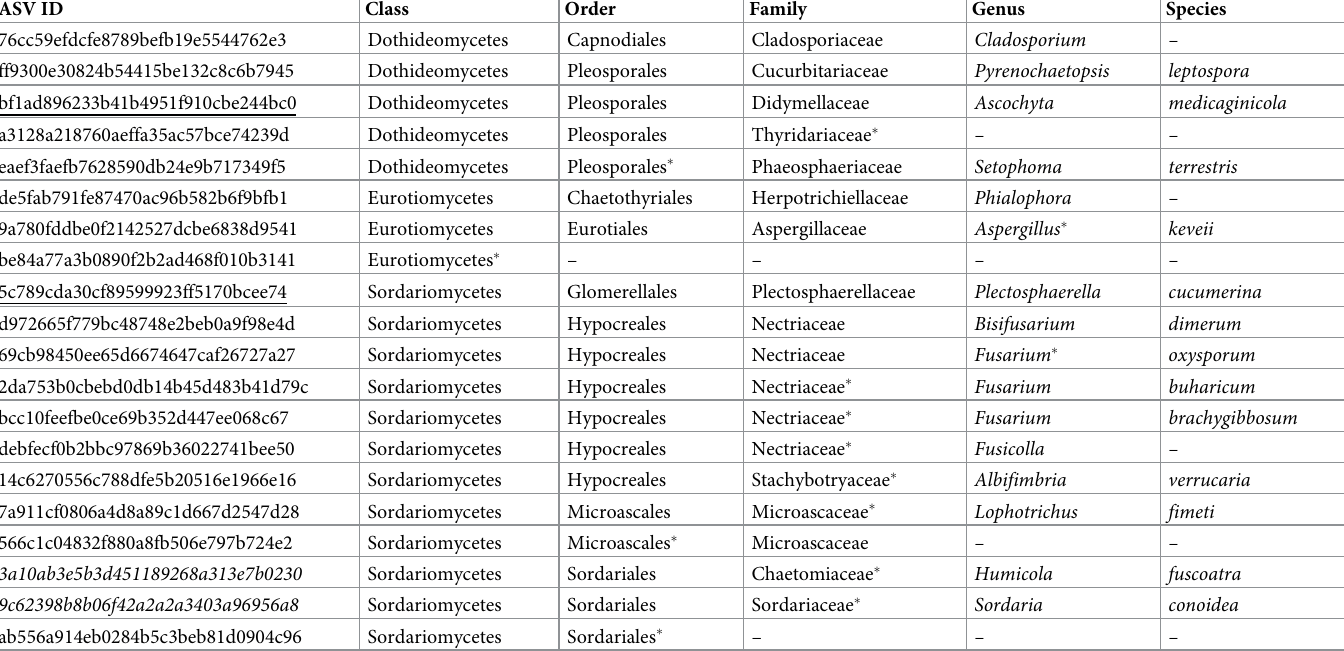
Table 3. Fungal ASVs strongly associated with the coffee bushes in both sun and shade systems and rarely found in the forest samples. All fungi belong to the Asco- mycota phylum. We used NCBI BLASTN 2.9.0+ to present greater taxonomic information, beyond what was assigned using QIIME2 (denoted by � ), if greater taxonomic information was available. Four ASVs could be categorized into a trophic mode using FUNguild and our criterion for assignment, two were ‘probable’ pathotrophs (ASV ID underlined) and two were ‘probable’ saprotrophs (ASV ID